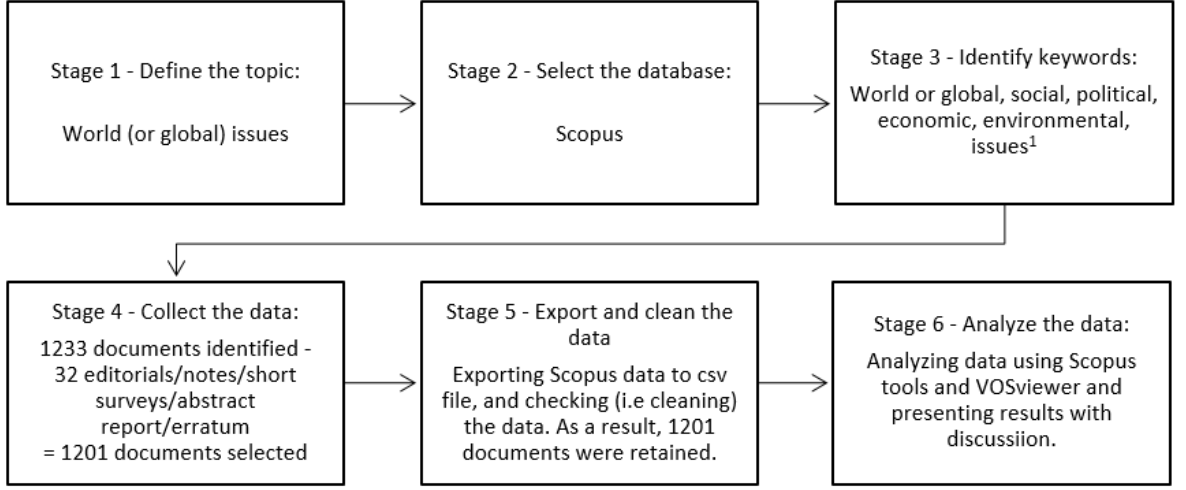
Figure 1. Process of bibliometric study. Note: 1 The keyword “issues” or “issue” produced the same search result. However, “issues” was used in the article because the study aimed to investigate “world (or global) issues” from a multi-dimensional perspective.